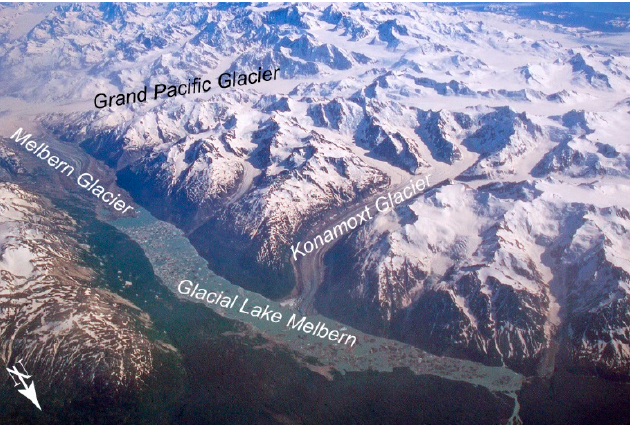
Figure 5. Glacial Lake Melbern, northwest British Columbia (compare with Figure 4). The lake is 20 km long and is impounded behind confluent Melbern and Grand Pacific glaciers northwest of Glacier Bay. An end moraine dams the lake at its north end. Photo by John Clague.